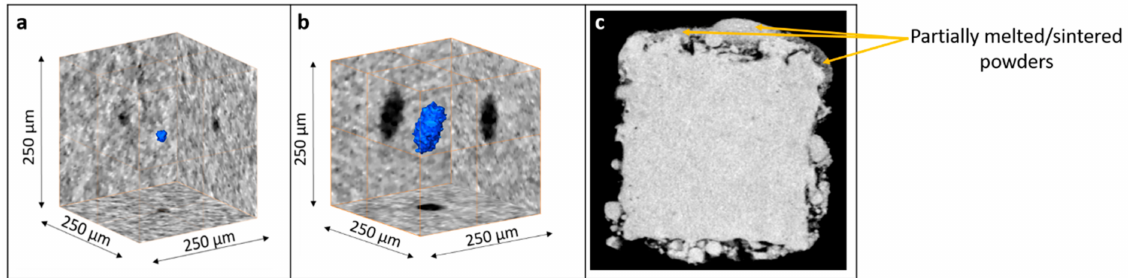
Figure 4. Different types of pores in L-PBF-printed red-gold samples characterized by neutron microtomography: ( a ) round pore, ( b ) large keyhole pore, and ( c ) partially melted/sintered powders at the edge of the printed